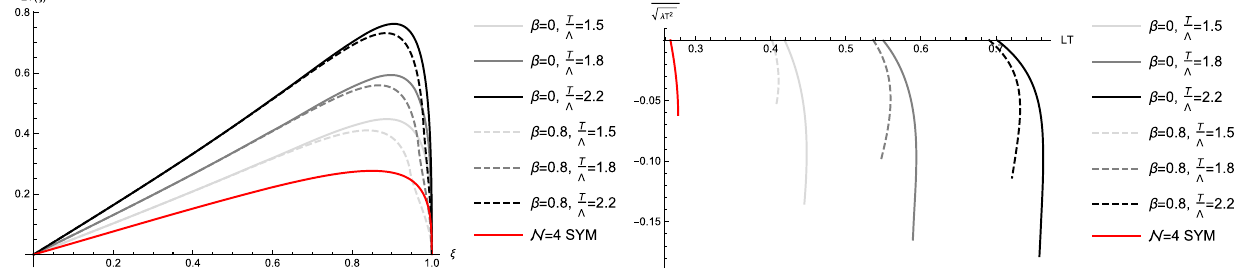
√ / λ T versus LT for different values of QQ